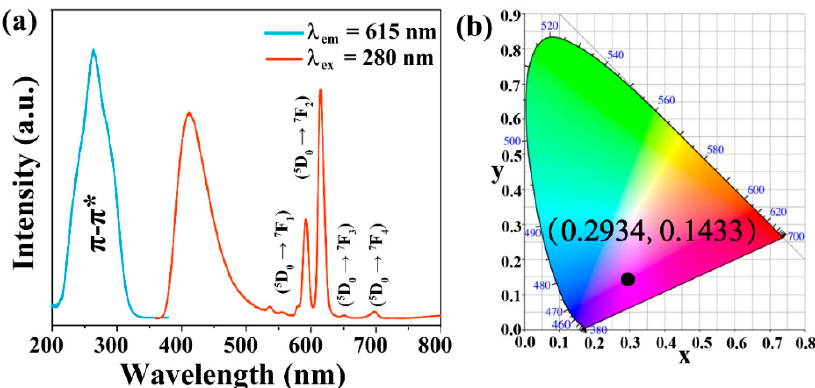
Figure 1. ( a ) The fluorescence of CDs-F2 and the screening of the excitation wavelength of the sam- ple. ( b ) The corresponding CIE chromaticity diagram of CDs-F2. ( b ) The corresponding CIE chromaticity diagram of